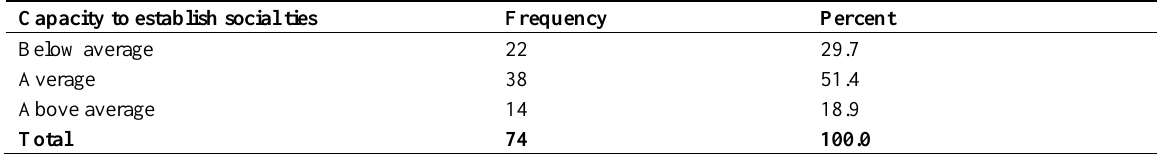
Table 9: Parents rating of Manager’s Networking Skills